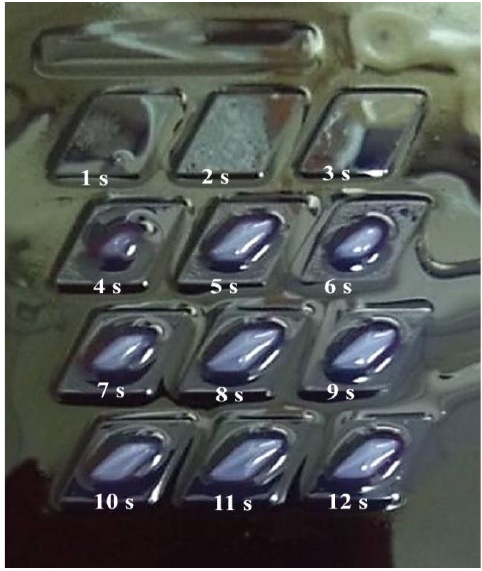
Figure 2. Curing times from 1 s to 12 s.